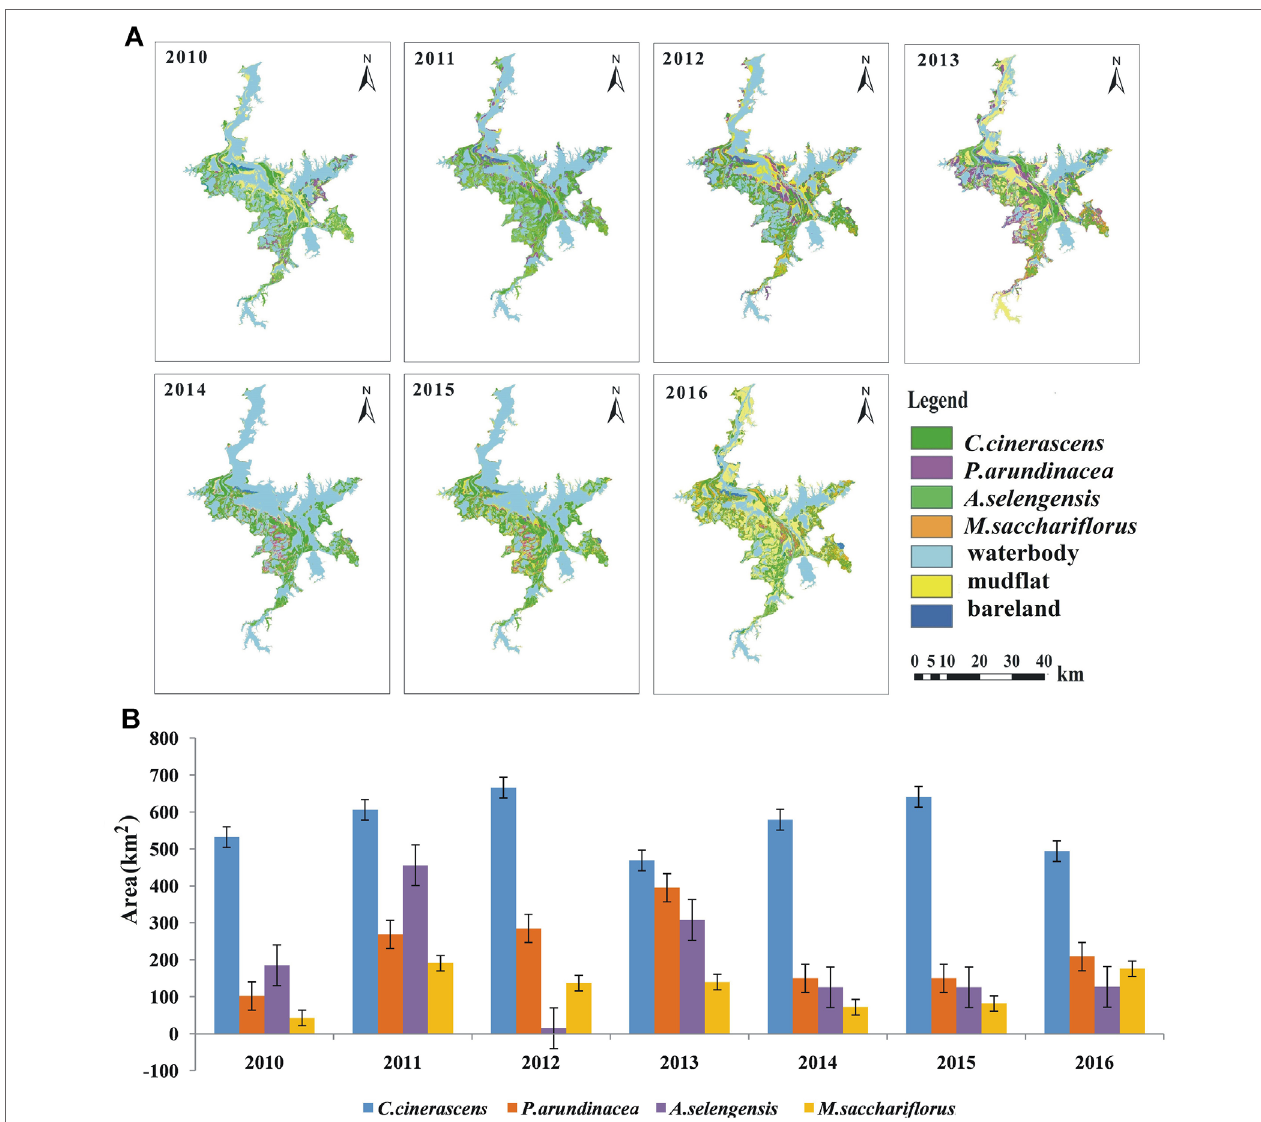
FIGURE 4 | Distribution of the main four vegetation types (A) and area statistics (B) from 2010 to